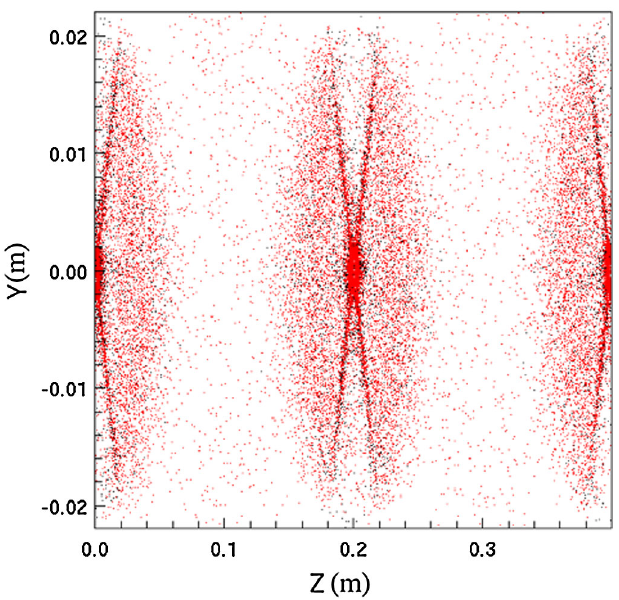
FIG. 11. Macroparticle distribution in the y - z plane at t ¼ 2 : 56 microseconds. Field nulls are at z ¼ 0 : 0 , 0.2, 0.4 m, and maxima of B y are at z ¼ 0 : 1 , 0.3 m. Red dots are secondary macro- electrons, black are primary macroelectrons.